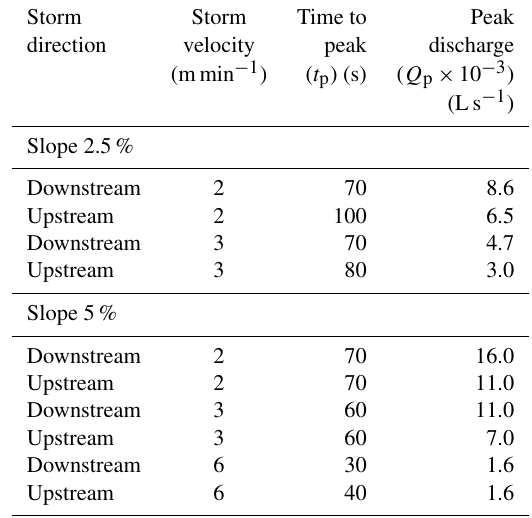
Table 3. Detailed moving storm characteristics of different scenar-